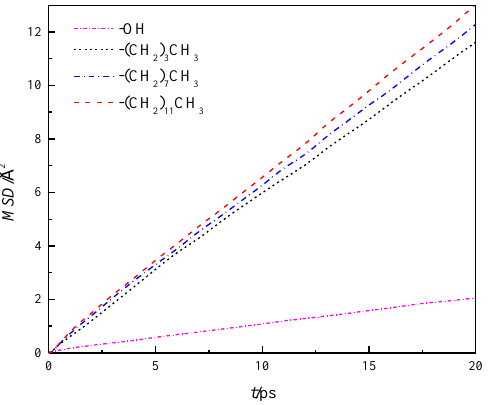
Figure 6. Overall average MSD of water in a nanochannel with different surface characteristics. Further analysis was made on the mean square displacement rate ( ∆ MSD ) of fluid water in the four wall features of the silicon dioxide nanochannel. By looking at the first derivative of the mean square displacement curve function, it is obtained that the 𝑀𝑆𝐷 𝑥\𝑦\𝑧 in each nanochannel is shown in the three directions of x , y and z , as shown in Figure 7, and the overall average MSD is shown in Figure 8.